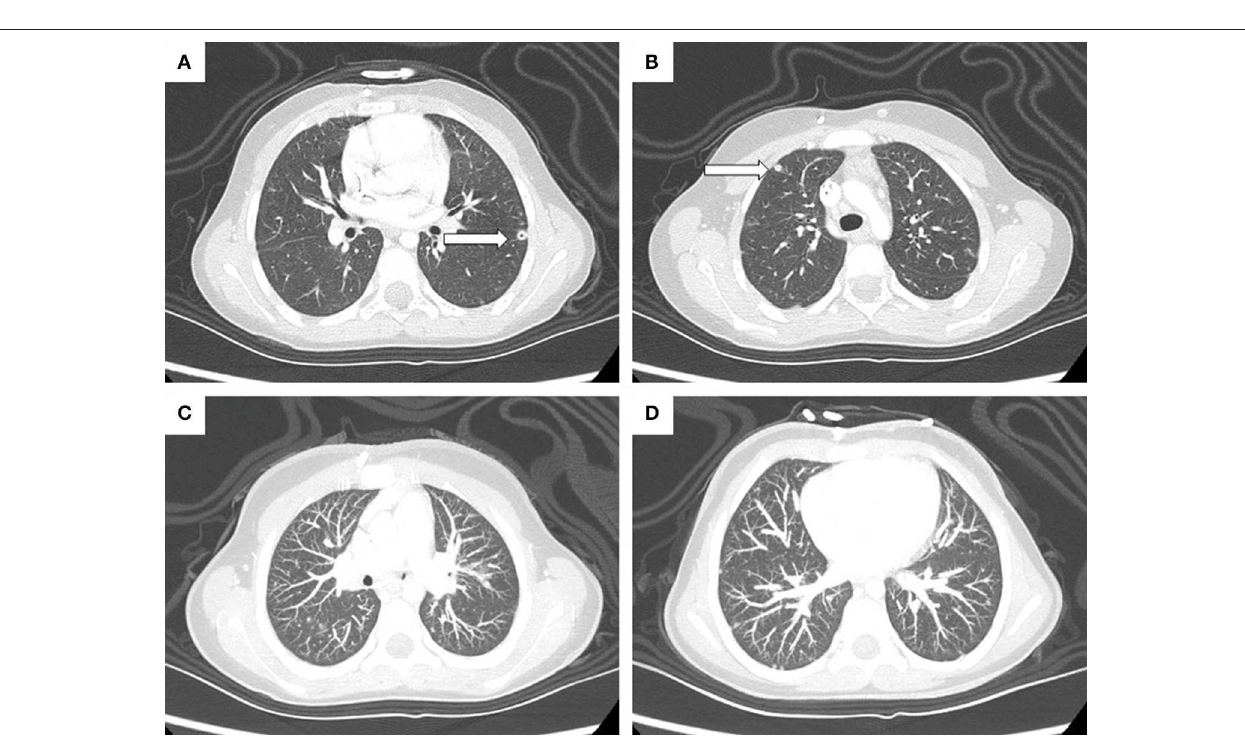
FIGURE 4 | High-resolution CT scan highlights a 6-mm cavitated nodule (arrow) in the anteromedial segment of the left inferior lobe (A) and a 5-mm subpleural nodule (arrow) in the anterior segment of the right superior lobe (B) . Maximum intensity projection (MIP) reconstruction image (C,D) shows the presence of multiple disseminated parenchymal and subpleural nodules (max.